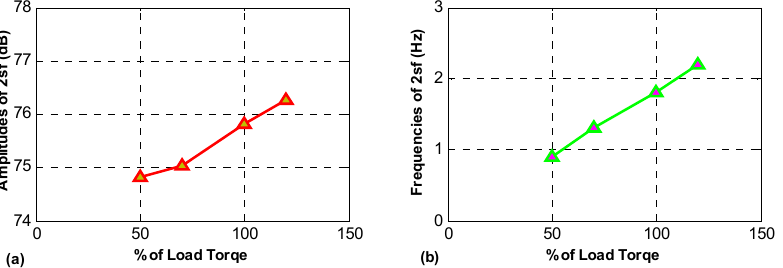
Figure 9. Park’s vector spectra of a motor with BRB and under different load conditions: ( a ) unloaded motor, ( b ) under 20% of nominal load, ( c ) under 50% of nominal load, ( d ) under 70% of nominal load, ( e ) under 100% of nominal load, and ( f ) under 120% of nominal load. Table 2. Amplitudes and frequencies of the 2· s · f s spectral components under different load condi- tions.